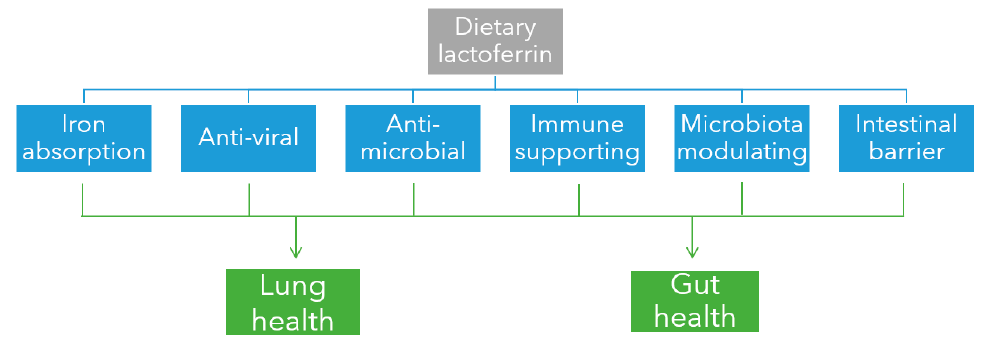
Figure 2. Physiological effects of LF (Blue) that support health of the 2 most affected organs in COVID-19 patients (Green).